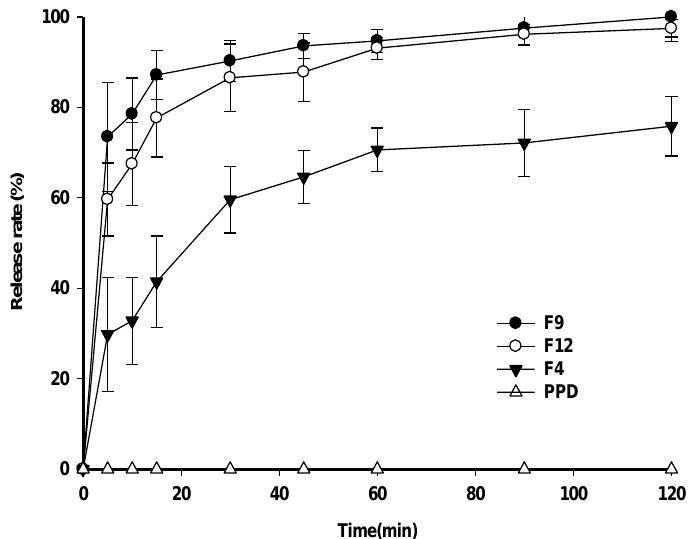
Figure 6. Dissolution profiles of PSP formulations in pH 1.2 buffer.